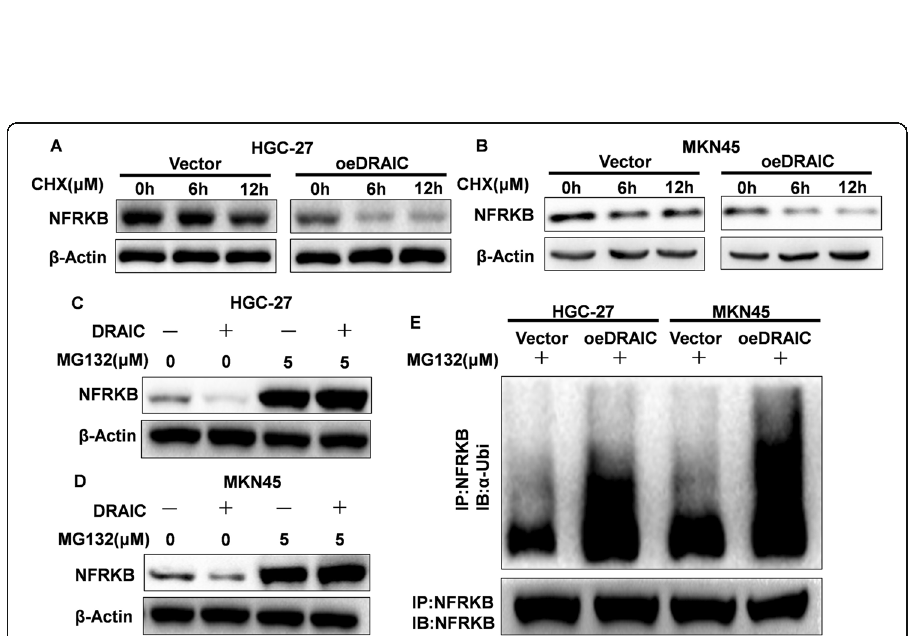
Fig. 4 The effect of DRAIC on the degradation and ubiquitination of NFRKB. a. The effect of oeDRAIC on the degradation of NFRKB in HGC-27. b. The effect of oeDRAIC on the degradation of NFRKB in MKN45. c. The blocking effect of proteasome inhibitor on the degradation of NFRKB mediated by oeDRAIC in HGC-27. d. The blocking effect of proteasome inhibitor on the degradation of NFRKB mediated by oeDRAIC in MKN45. e. The effect of oeDRAIC on the ubiquitination level of